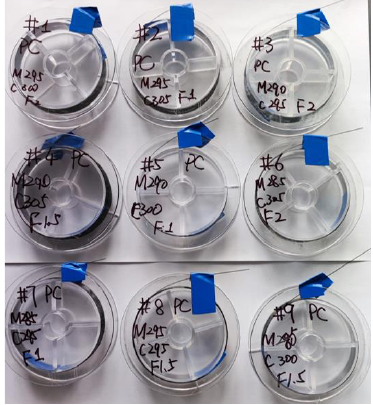
Figure 6. CFRPF prepared by orthogonal test.